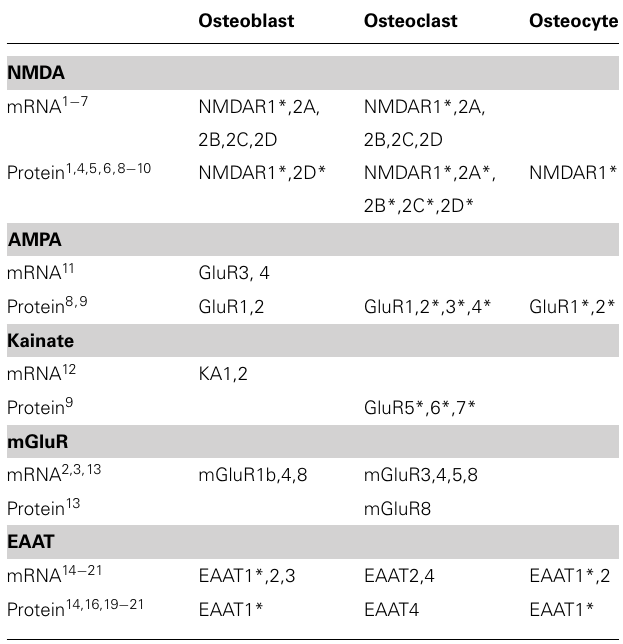
Table 1 | Reported transcript and protein expression of glutamatergic signaling components in bone cells. Osteoblast